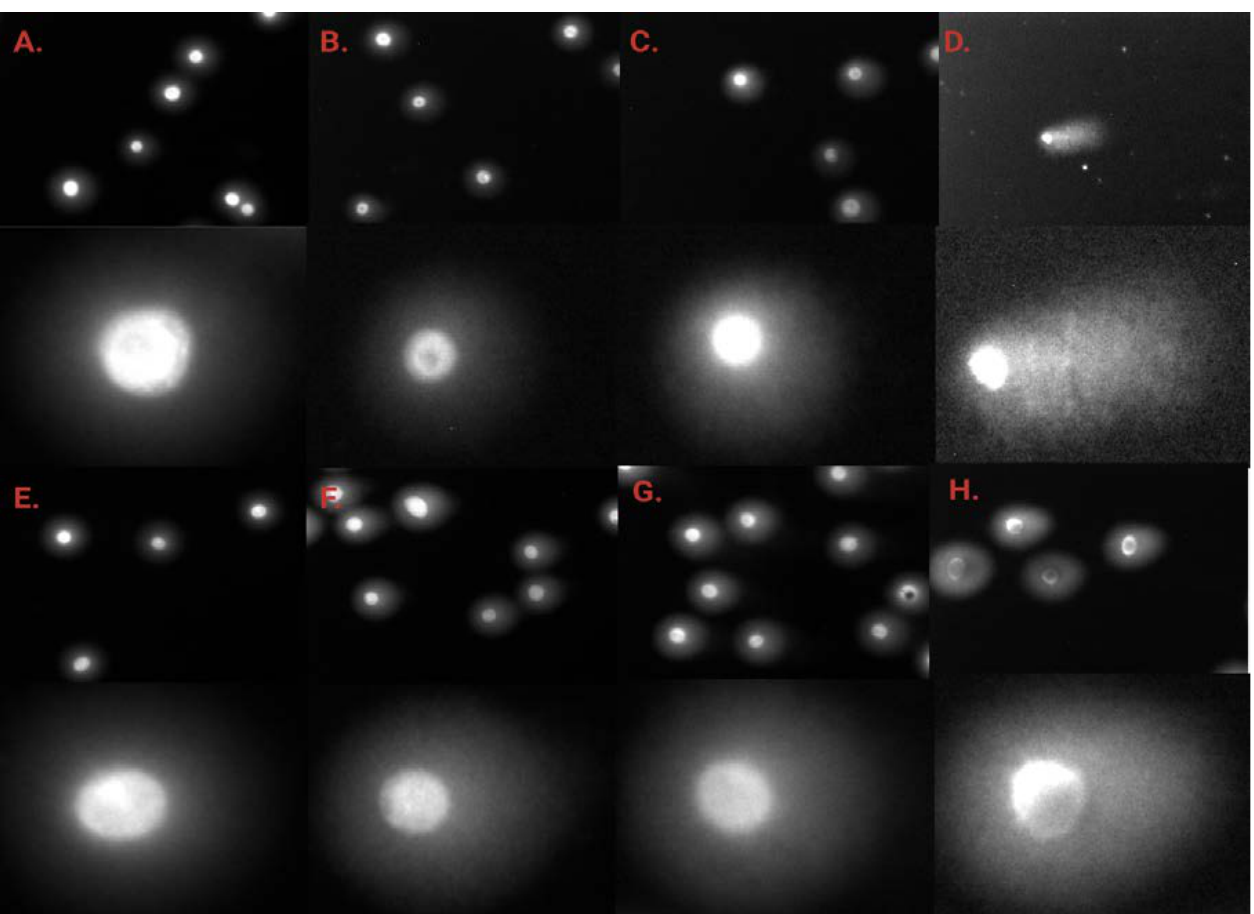
Figure 9. Neutral comet assay results: images of comets obtained in neutral comet assay for the BxPC-3 ( A – D ) and PC-3 ( E – H ) cells after incubation with MM134 ( A ) control samples, ( B ) cells treated with 0.5 × IC 50 , ( C ) IC 50 and ( D ) 2 × IC 50 concentrations of the tested compound, and MM139 ( E ) control samples, ( F ) cells treated with 0.5 × IC 50 , ( G ) IC 50 and ( H ) 2 × IC 50 concentrations of the tested compound. Upper images are shown in magnification of 20×. Lower images are shown in arbitrary magnification.